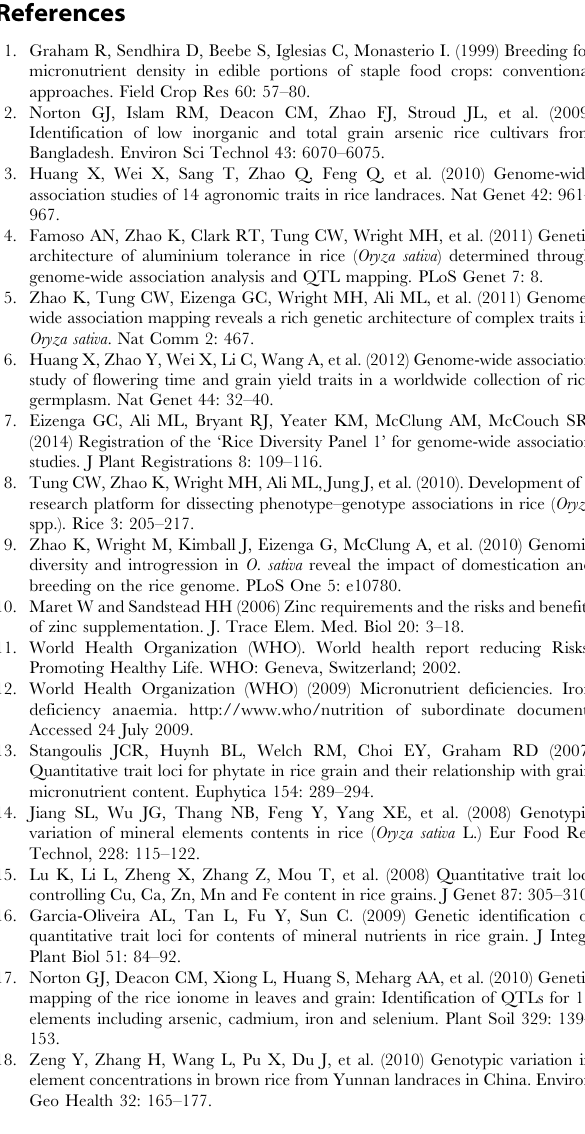
Table S5 List of significant SNPs associated with the accumulation of molybdenum within rice grains. Table S6 List of significant SNPs associated with the accumulation of zinc within rice